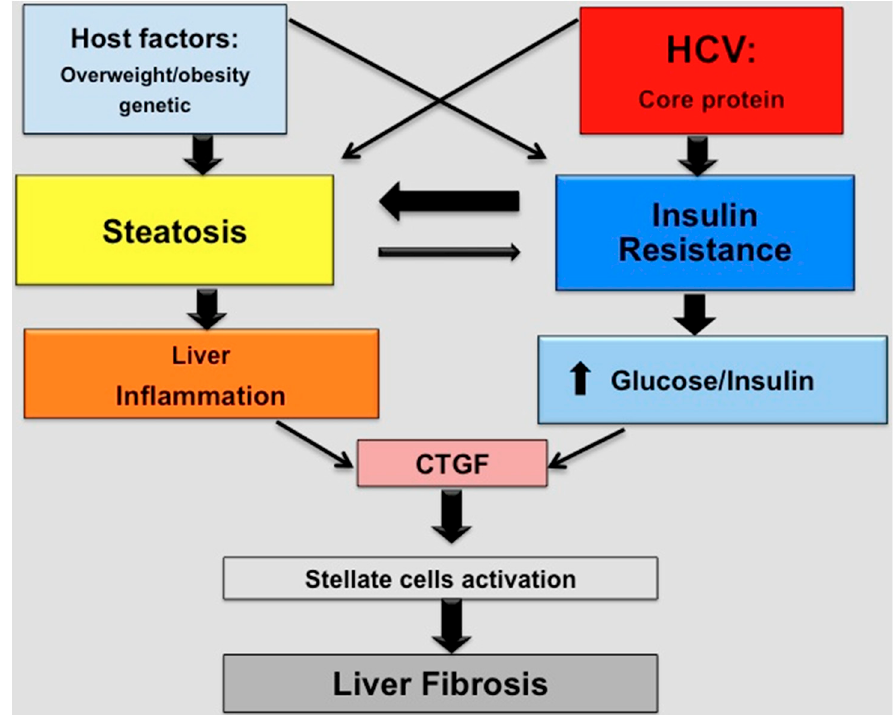
Figure 2. Schematic representation of factors and mechanisms involved in the progression of liver fibrosis in chronic hepatitis C patients. HCV: hepatitis C virus: CTGF: connective tissue growth factor.